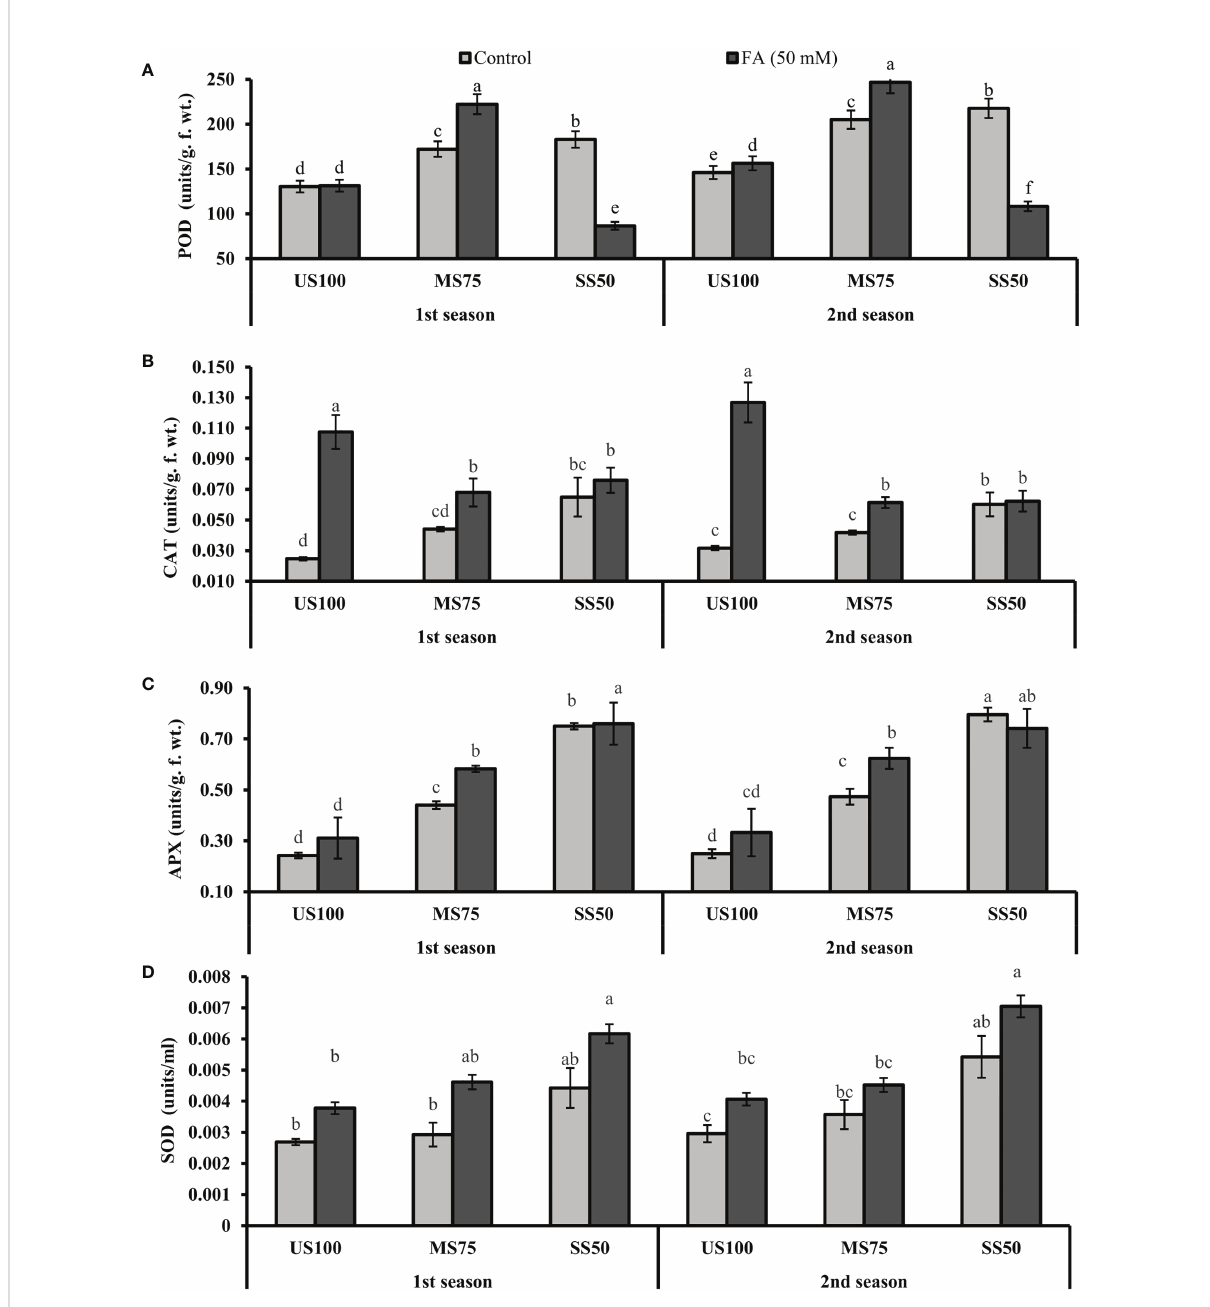
FIGURE 7 Effect of foliar application of folic acid (50 mM) on antioxidative enzymes (A) peroxidase, (B) catalase, (C) ascorbate peroxidase, and (D) superoxide dismutase in the fi rst and second seasons. The graph values are the mean ± SE of four replicates. The bars exhibited with different letters indicate a signi fi cant difference between samples by least signi fi cant difference ( p ≤